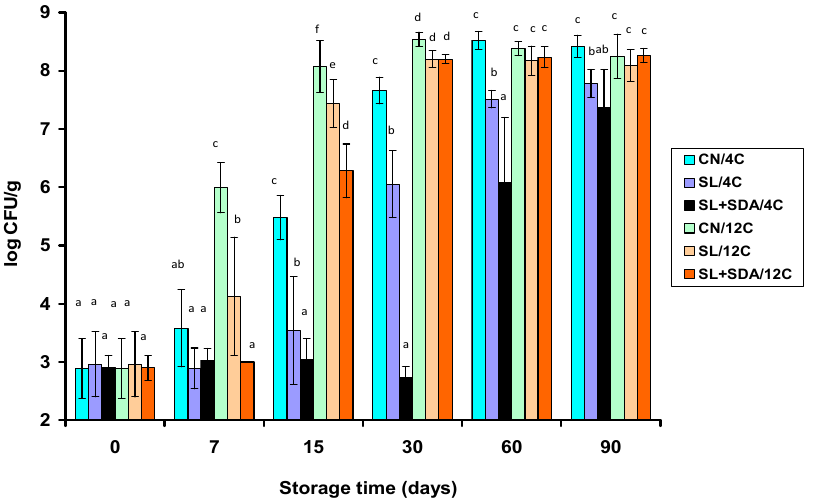
Figure 2. Mean total spoilage bacterial (TSAYE/30 °C) populations ( n = 4) grown on vacuum-packaged frankfurters during storage at 4 °C and 12 °C. Frankfurter treatments contained 1.8% sodium lactate (SL), or 1.8% SL and 0.25% sodium diacetate (SL + SDA). Frankfurters without preservatives served as controls (CN). Whiskers for each point value in the graph indicate standard deviations. Mean value bars within each sampling time interval bearing different lowercase letters are significantly different ( p < 0.05).